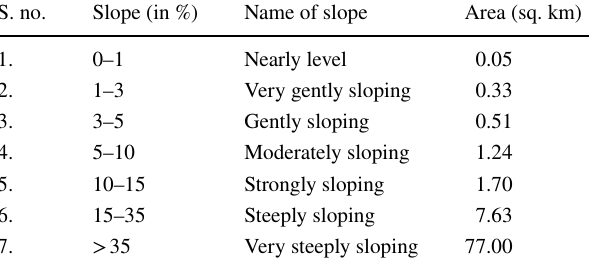
Table 1 Showing areawise distribution of slope (in %) S.